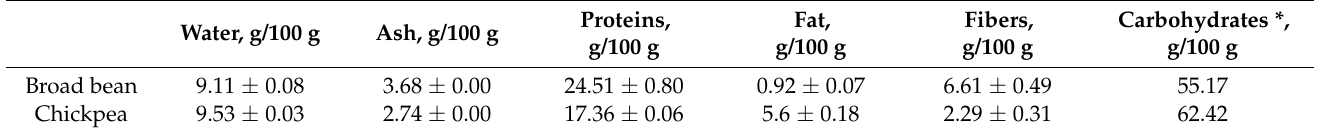
Table 1. Proximate composition of studied legume flours.